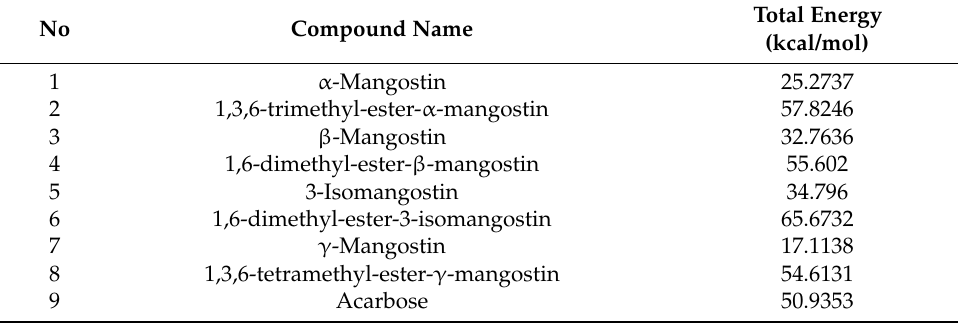
Table 1. The total energy value from the minimization result by calculating MM2. No